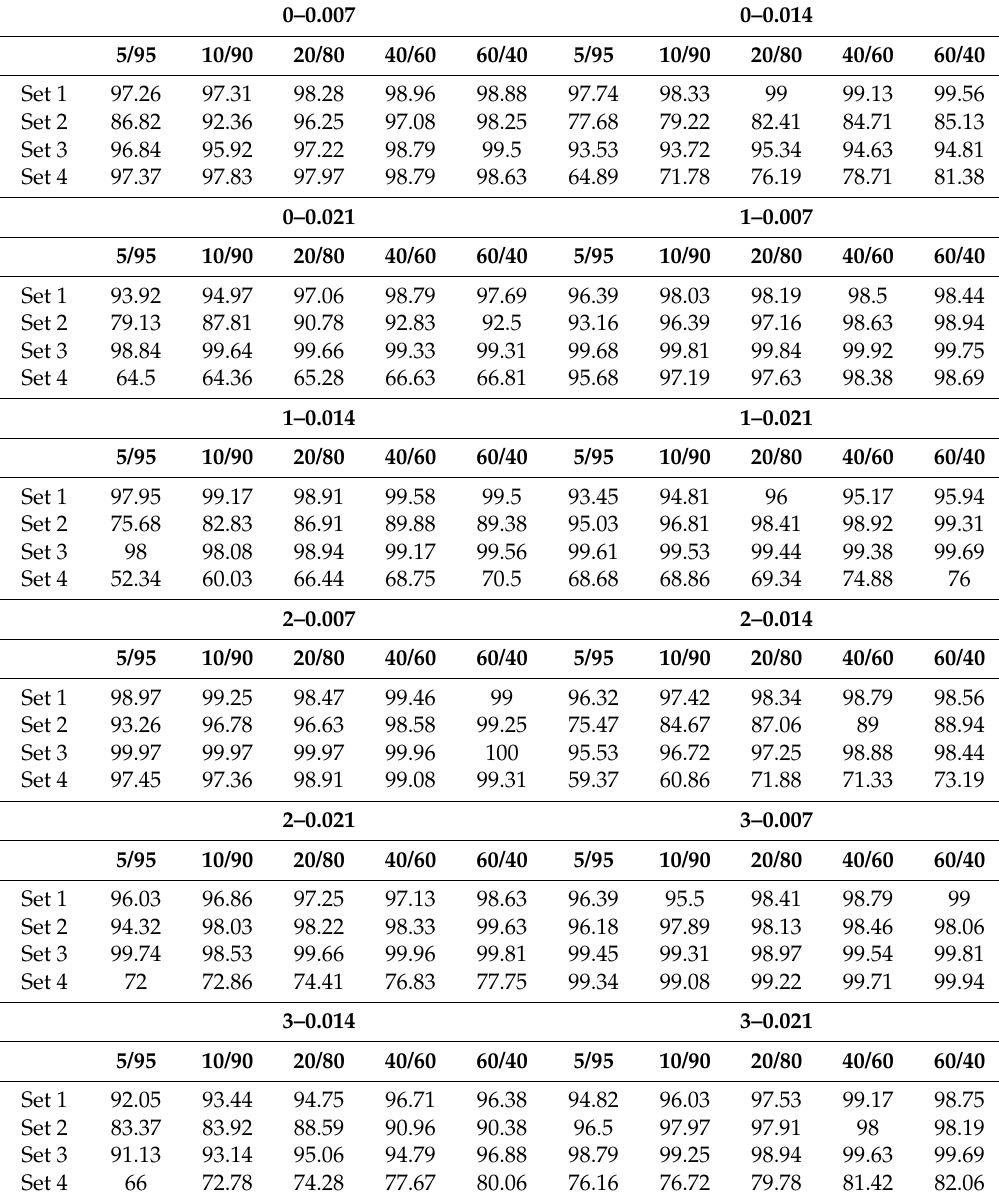
Table 7. Average diagnostic accuracy to all independent experiments corresponding to 12 different working conditions respectively with different schemes in 1st–4th experiment